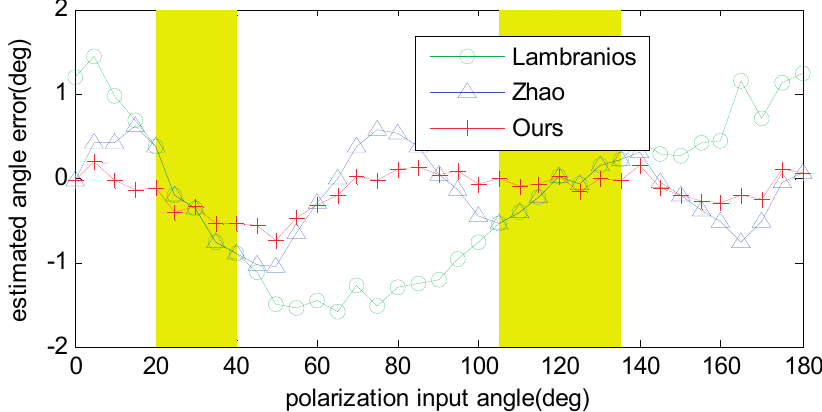
Figure 5. Angle estimation error comparison of different algorithms before calibration.